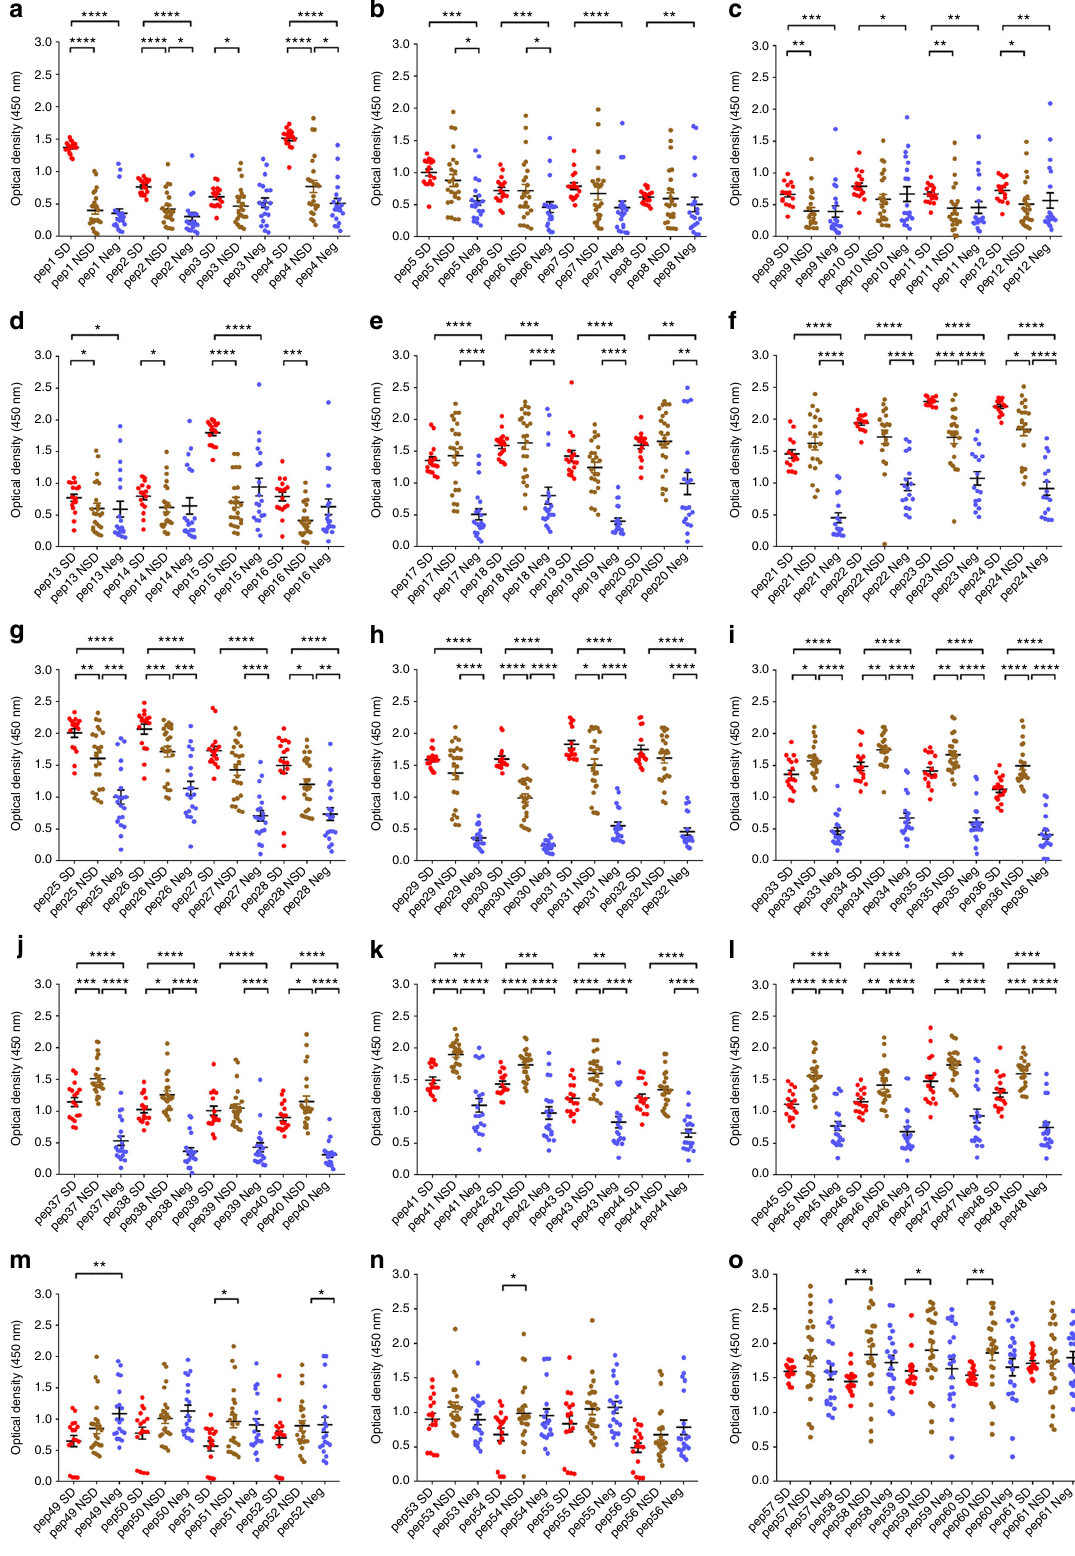
Fig. 9 NS1-antibody responses in individuals with past infection. a – o DENV1 NS1-speci fi c IgG antibody responses to DENV-1 NS1 overlapping peptides 1 – 61 in seronegative individuals (Neg, n = 20), those with past non-severe dengue (NSD, n = 24) and past severe dengue (SD, n = 17). Error bars represent mean and standard deviation. Differences between the groups were compared using the Mann – Whitney U test (two tailed). * P < 0.05, ** P < 0.01, *** P < 0.001, **** P <